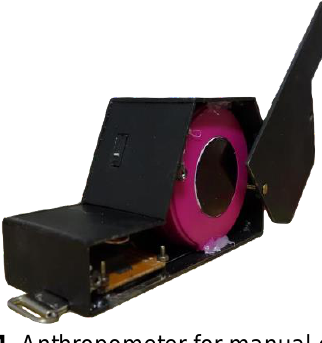
Figure 4. Anthropometer for manual extraction of human body parameters.